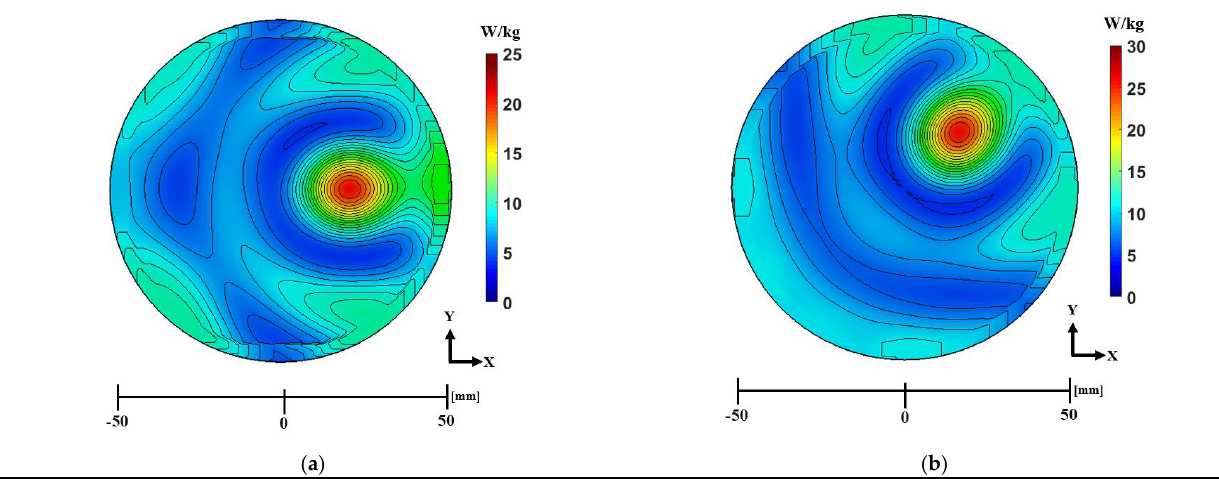
Figure 6. The 2D section of SAR distributions focused at different tumor positions: ( a ) (20,0) mm and ( b ) (15,15) mm. Table 2. Calculated input phases for unifocal breast cancer. Position of Antenna Number Single Tumor (𝒙 𝐭𝟏 ,𝒚 𝐭𝟏 )